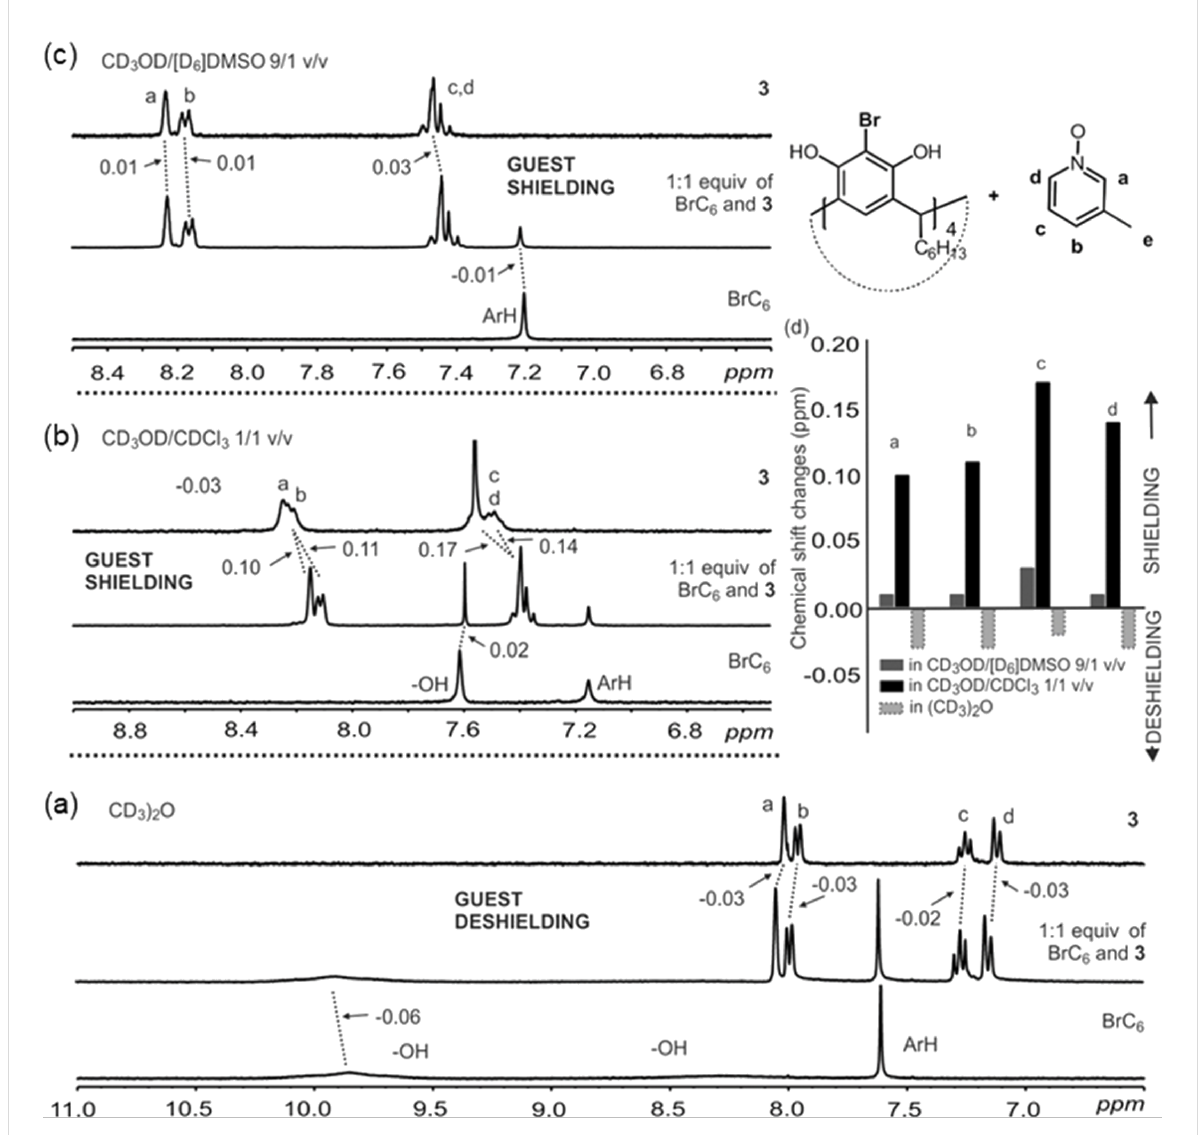
Figure 5: An expansion of the 1 H NMR (6.6 mM at 298 K, 500 MHz) of BrC6 complexes with 3 . Spectra are produced from BrC6, 3 and an equimolar mixture of BrC6 and 3 in: (a) (CD 3 ) 2 O, (b) CD 3 OD/CDCl 3 1:1 v/v, and (c) CD 3 OD/DMSO- d 6 9:1 v/v. Dashed lines highlight the observed shift changes of the resonances, labels are in ppm. (d) Bar chart showing the comparative shift changes of the guests in the different solvent media.